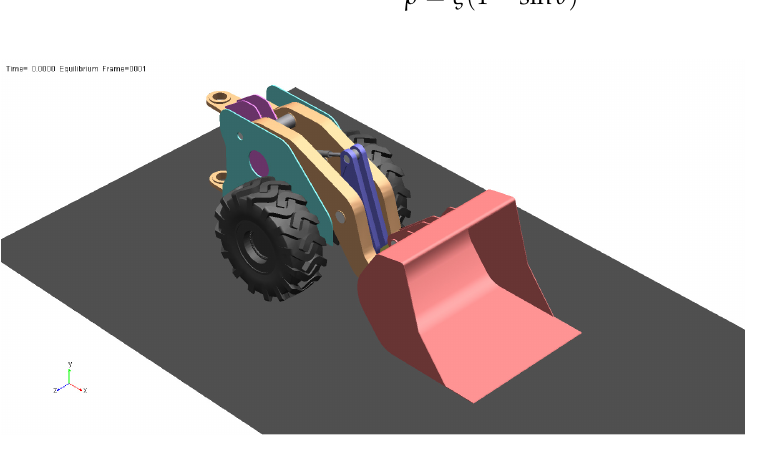
Figure 7. Virtual prototype in